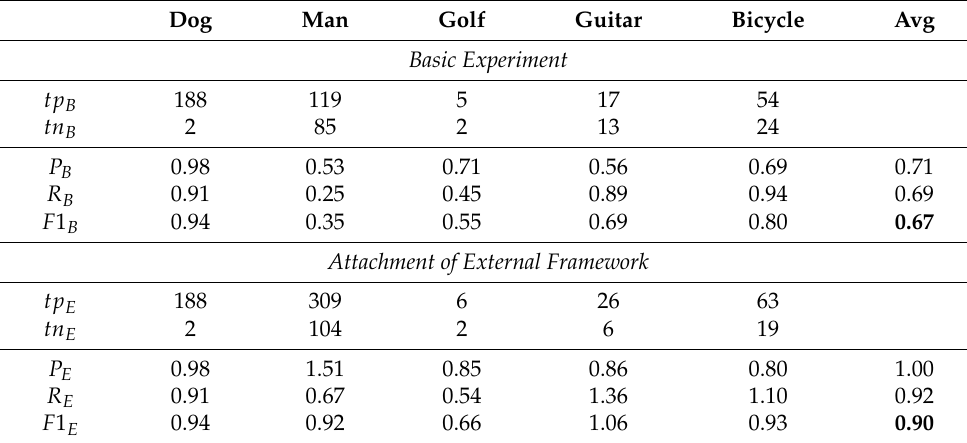
Table 4. Effectiveness based on the Flickr30k dataset. Dog Man